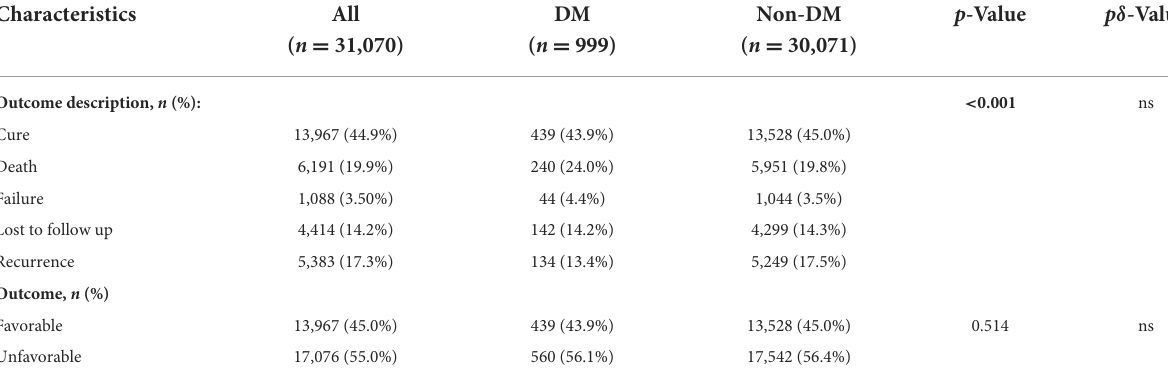
TABLE 1 Comparison of treatment outcomes between TB-HIV and TB-HIV-DM population.